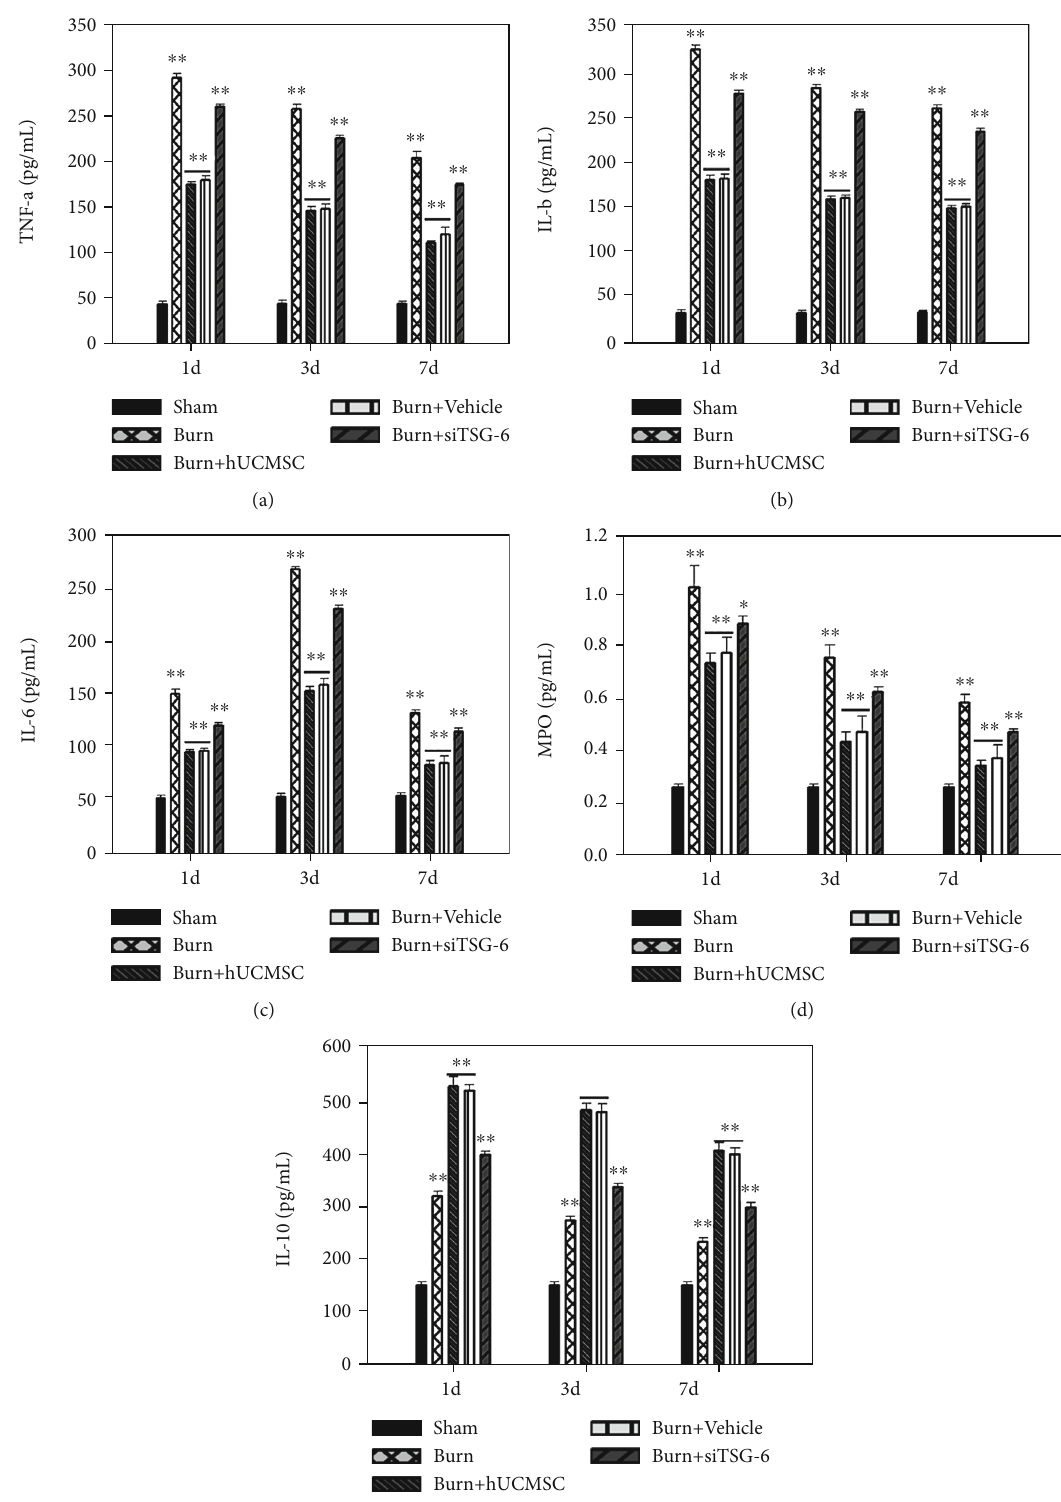
Figure 5: E ff ect of TSG-6 secretion and knockdown on in fl ammatory cytokines of lung tissues induced by severe burn. The e ff ects of TSG-6 secretion and knockdown on TNF- α (a), IL-1 β (b), IL-6 (c), MPO (d), and IL-10 (e) levels of lung tissue at 1 d, 3d, and 7d postsevere burn, respectively. Values are represented as mean ± SD ( n = 6 ). Asterisk ( ∗ ) and double asterisk ( ∗∗ ) stand for p < 0 : 05 and p < 0 : 01 ,